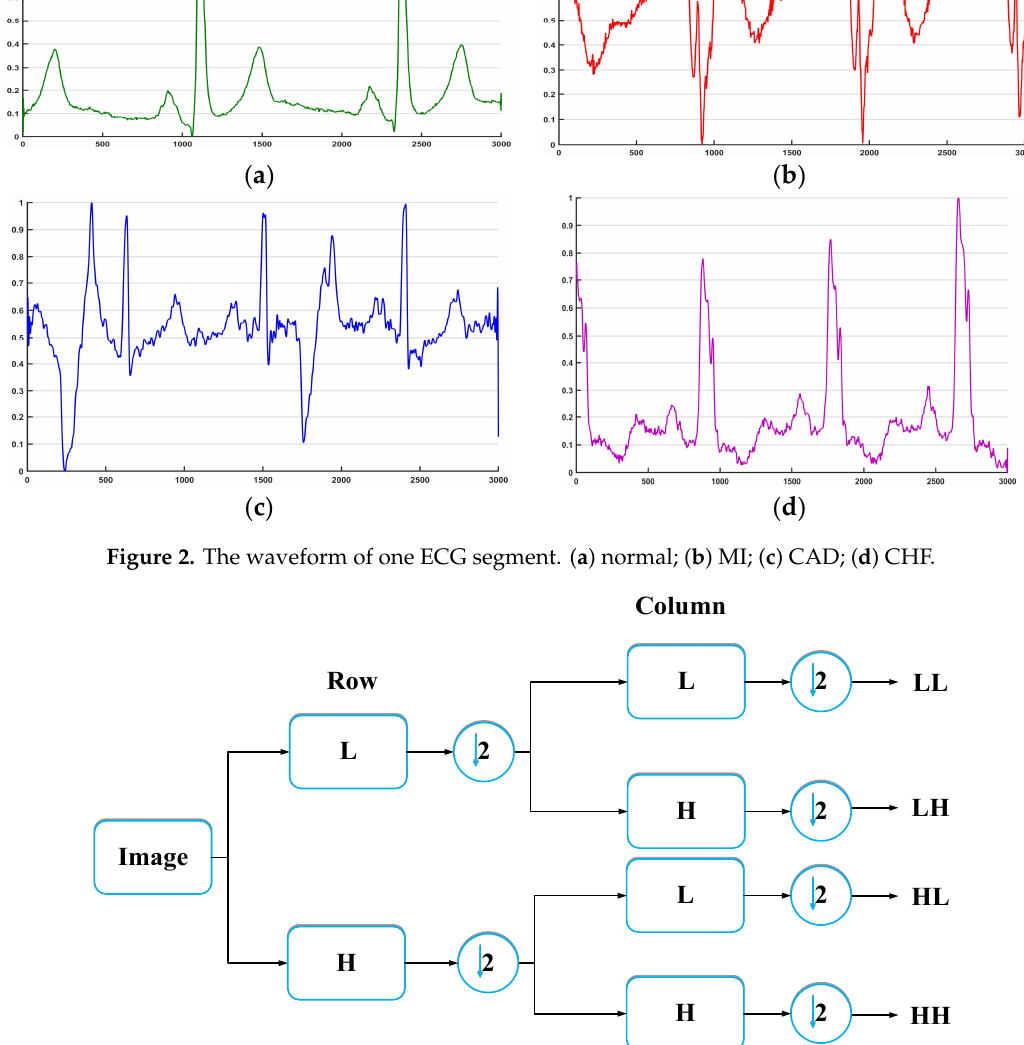
Figure 4. Two-level 2D-DWT for raw ECG matrix. 3.5. Feature Extraction (MDD-Net) In the field of computer vision, CNNs, such as the recent VGG-Net [30], GoogLeNet [31], Inception [32], and other models, are now commonly used. A milestone in CNN history was the emergence of the ResNet [33] model. The core of the ResNet model is establishing “shortcuts and skip connections” between the front and back layers, which is helpful in the backpropagation of the gradient in the training process used to train a deep CNN. Benefiting from the basic concept of ResNet, DenseNet [34] establishes dense connections between among the front layers and the back layers. Compared with ResNet, DenseNet has fewer parameters and mitigates vanishing gradient and model degradation issues since there are direct connections from the low- to high-level layers, which can be represented as follows: